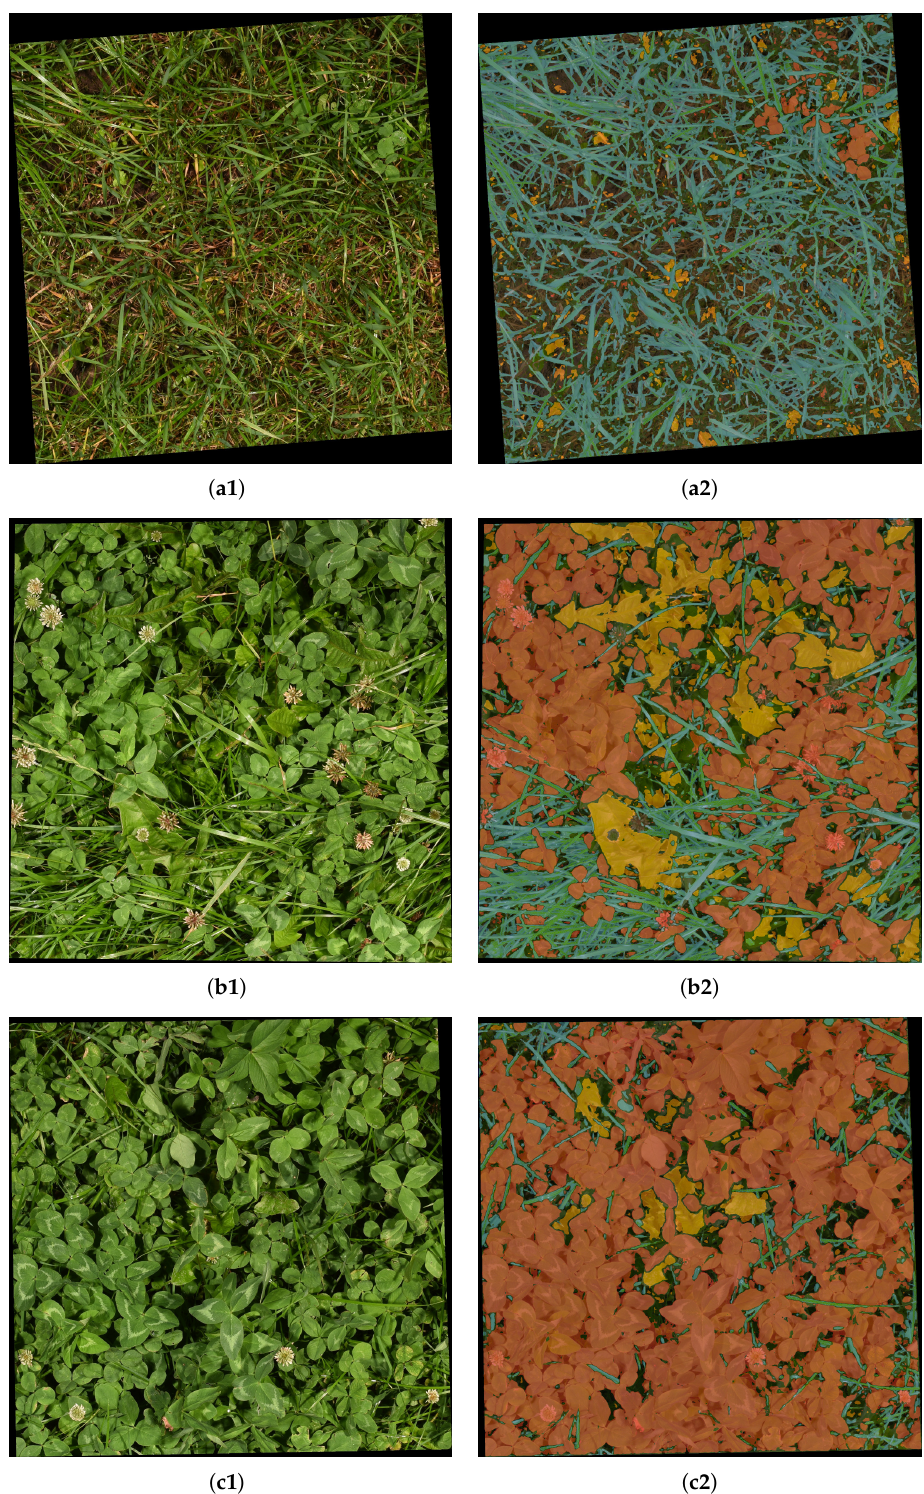
Figure 9. Visualization of CNN-driven semantic segmentation of highlighted sample pairs from Figure 10. The first column shows the evaluated image. The second column shows the thresholded identification of grass (blue), clover (red), and weeds (yellow) in the image. ( a1 ) Low clover fraction; ( a2 ) Semantic segmentation of (a1); ( b1 ) Medium clover fraction; ( b2 ) Semantic segmentation of (b1); ( c1 ) High clover fraction; ( c2 ) Semantic segmentation of